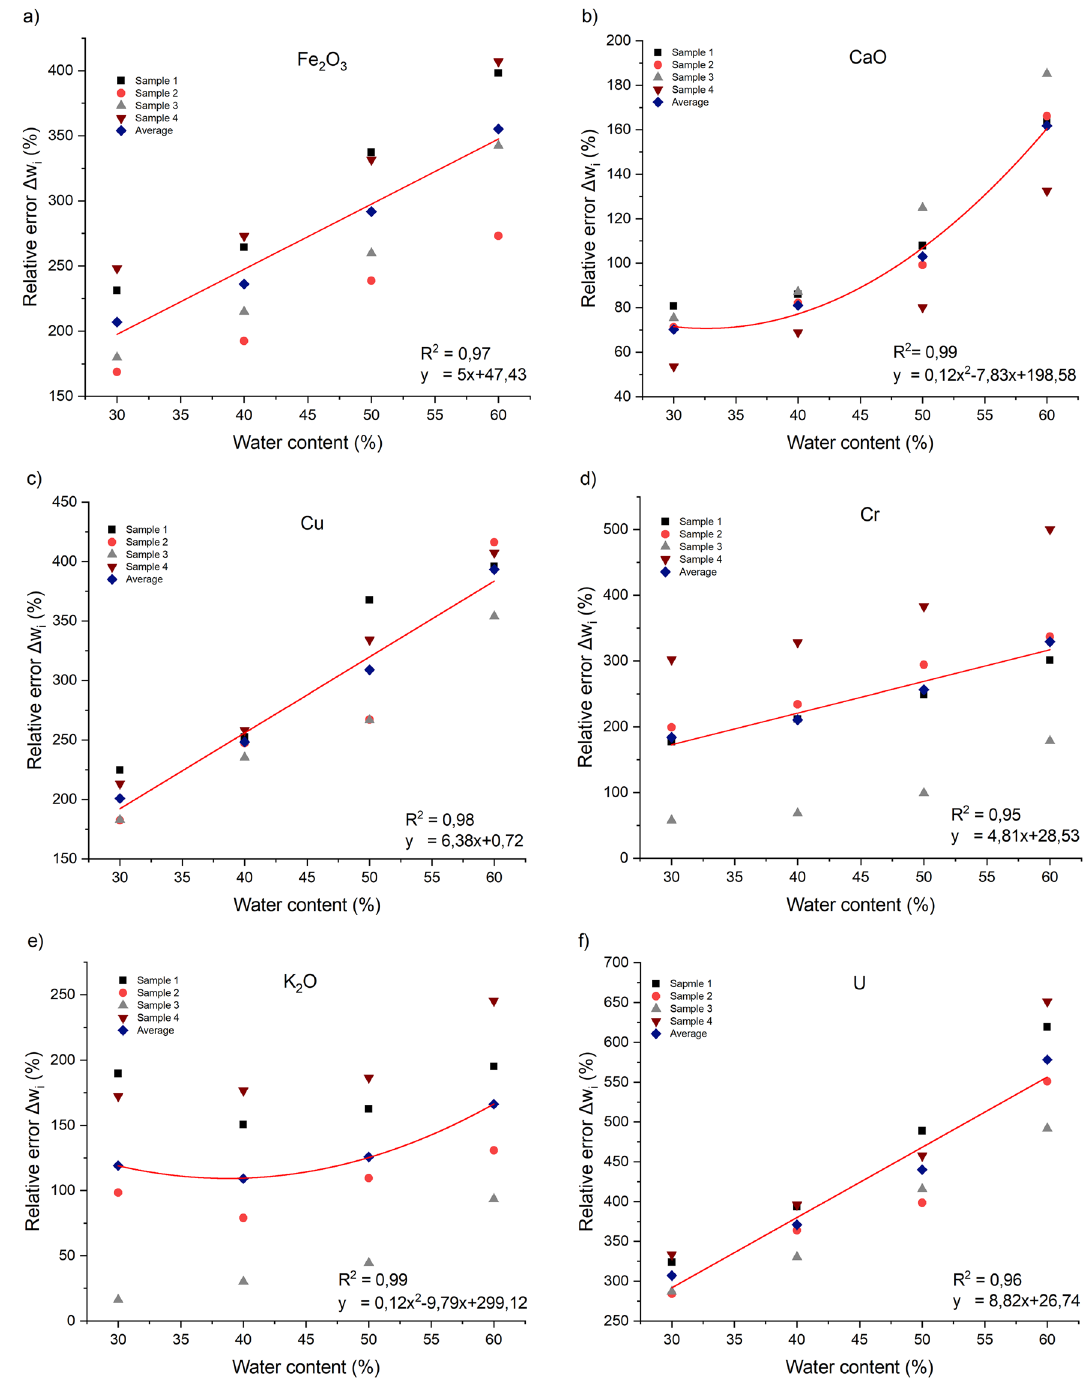
Figure 7. The relative error of XRF measurements as a function of water content. ( a ) Fe 2 O 3 , ( b ) CaO, ( c ) Cu, ( d ) Cr, ( e ) K 2 O, ( f ) U, ( g ) SO 3 , ( h ) As, ( i ) Zn, ( j )